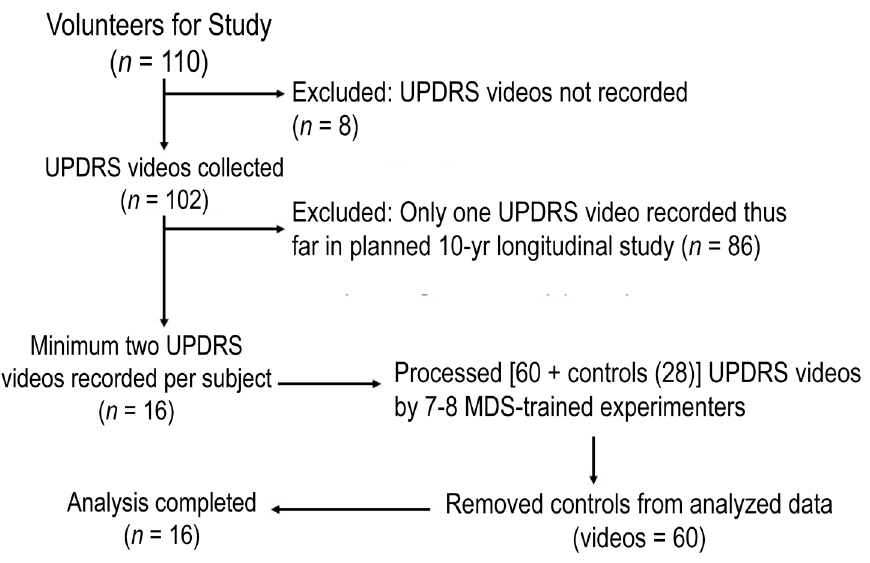
Figure 1. Flow chart of enrolment.